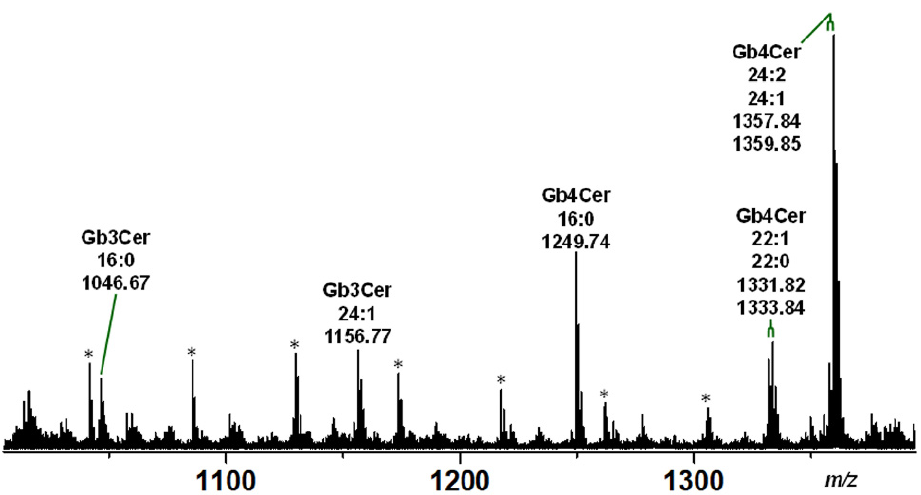
Figure 2. Overview MS 1 spectrum of Stx receptor GSLs Gb3Cer and Gb4Cer of serum-free cultivated pHCoEpiCs. The spectrum was obtained from a GSL preparation of replicate 2 (R2; see Figure 1) showing the various lipoforms of Gb3Cer and Gb4Cer harboring sphingosine (d18:1) as the sole sphingoid base and variable fatty acids as indicated. All GSLs were detected as monosodiated species using the positive ion mode and are listed in Table 1. The [M+Na] + ions of Gb3Cer at m/z 1046.67 and 1156.77 and those of Gb4Cer at m/z 1249.74 and 1357.84/1359.85 were selected for MS 2 analysis as shown in Figures 3 and 4, respectively. The asterisks mark polyethylene glycols (PEGs) appearing as serial contaminations in the GSL